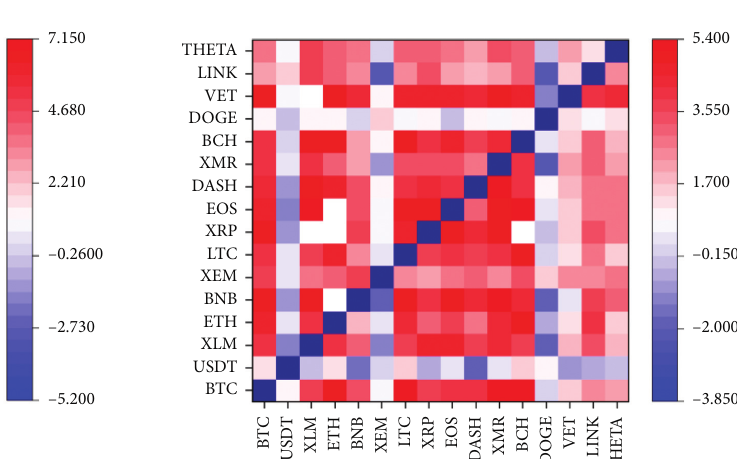
Figure 3: Causality test under D2.